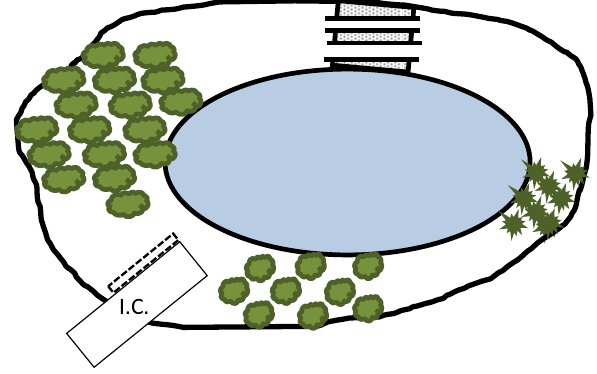
FIG. 4. School yard with a narrow bridge over the ditch.